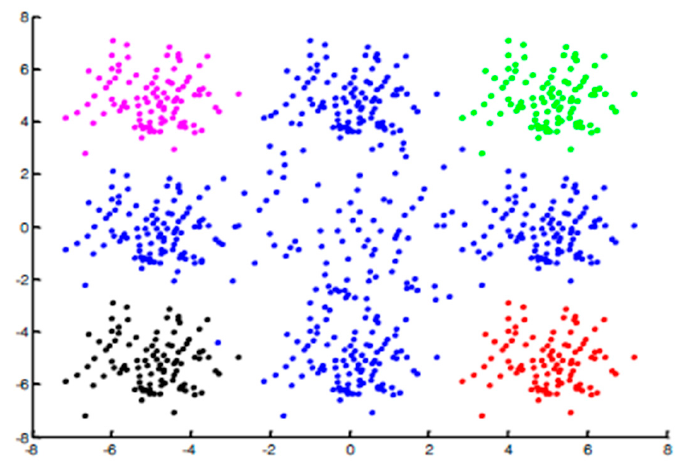
Figure 1. The positive class consists of four subgroups. The negative class is in blue color. Each cluster has a different color (pink, green, black, and red).